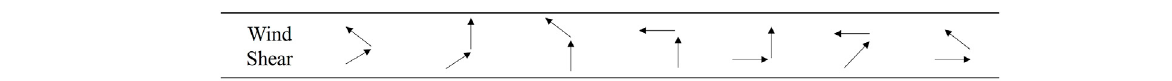
TABLE 1 | Details of selected WRWS cases with durations of more than 6 h over coastal areas of YHR in 2017. Case Duration of precipitation processes (BJT)